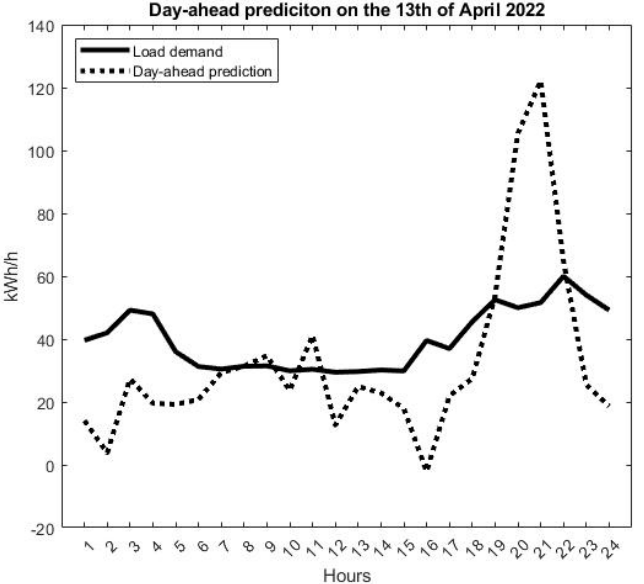
Figure 6. The mobility house’s load demand profile and the day-ahead predicted load demand profile on the 13th of April 2022, which was the day with the highest RMSE in the testing data set.